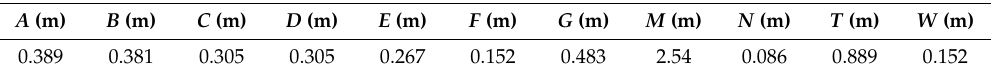
Figure 21. Comparison of experimental and simulated results along the flume: ( a ) water surface; ( b ) x -directional velocity. Table 2. Values of parameters of the